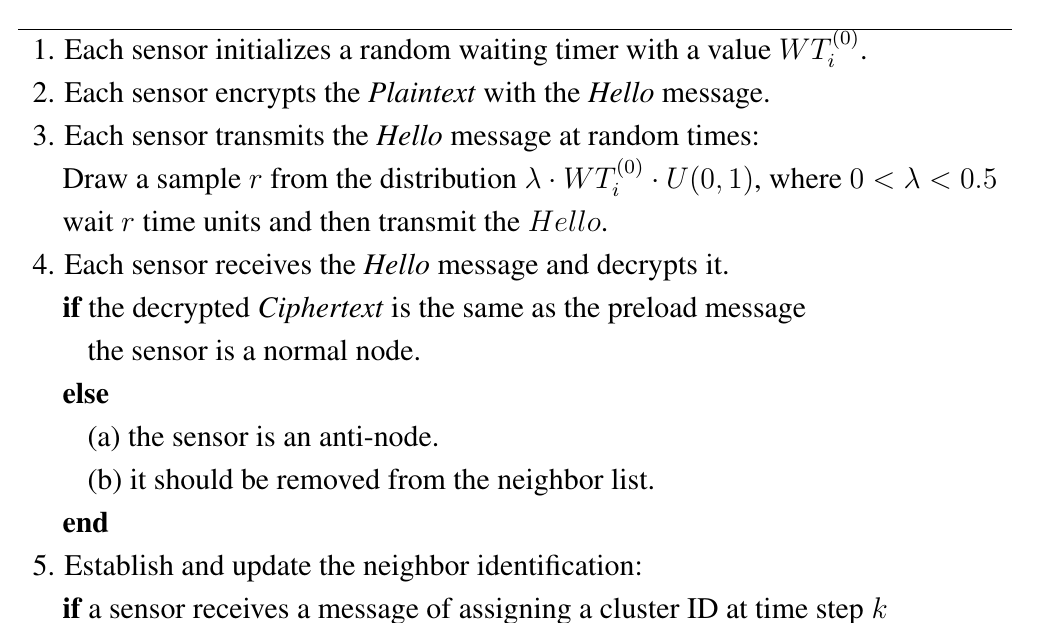
Table 1. Secure Cluster